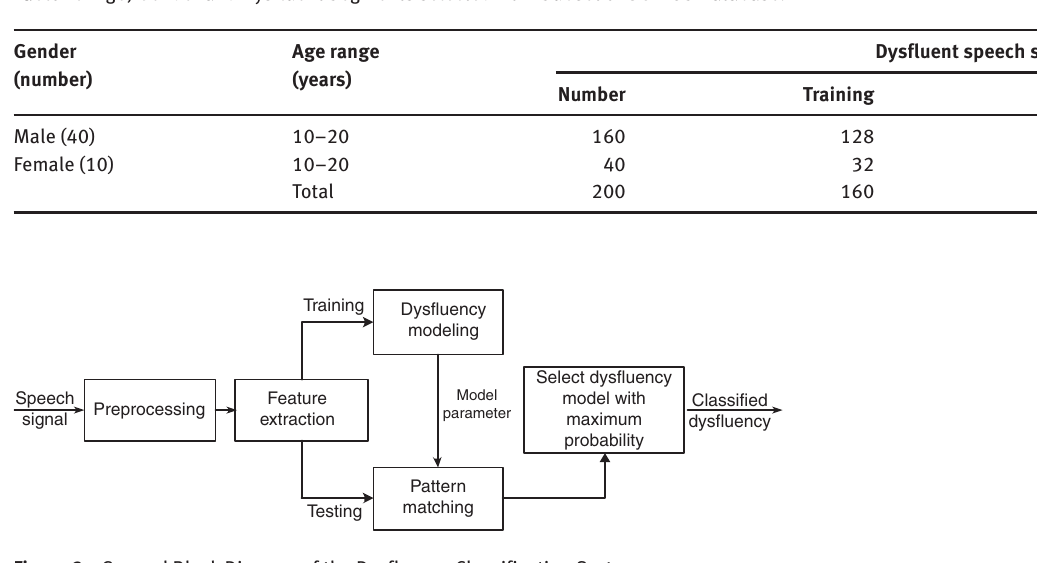
Figure 2: General Block Diagram of the Dysfluency Classification